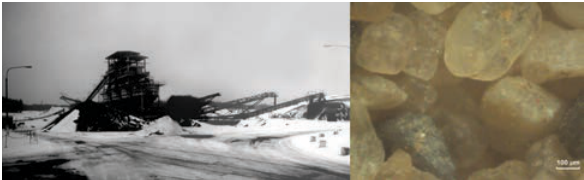
Fig. 1. Aggregate pit in Sępólno Wielkie and its fine aggregate